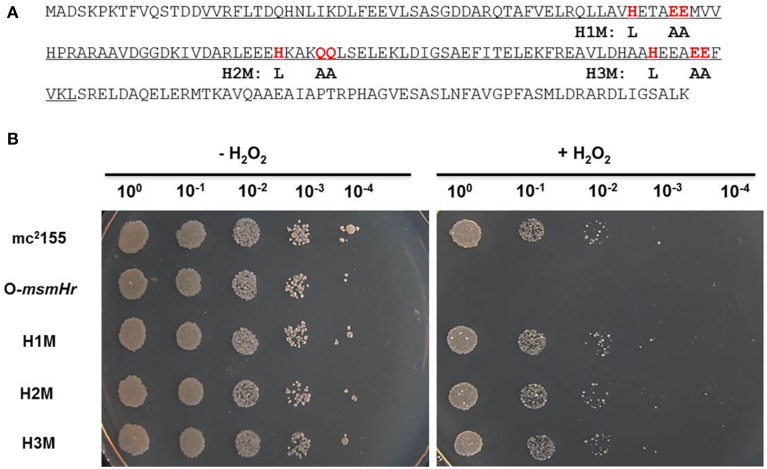
The hemerythrin domain is essential to MsmHr function. (A) The hemerythrin domain (underlined) of MsmHr and conserved amino acids (H… EE/QQ: red and boxed) in the hemerythrin domain are indicated. Mutations used in the following experiments are indicated under the sequence. (B) Serial dilutions (1:10) of mc2155, pMV261-msmHr/mc2155 (O-msmHr), pMV261-msmHrH1M/mc2155 (H1M), pMV261-msmHrH2M/mc2155 (H2M) and pMV261-msmHrH3M/mc2155 (H3M) treated with 0 (left) or 5 mM (right) H2O2 were spotted (3 μl) onto solid 7H10 agar. Photographs were taken after 2–3 days incubation at 37°C. Images shown are representative of at least 3 experiments.